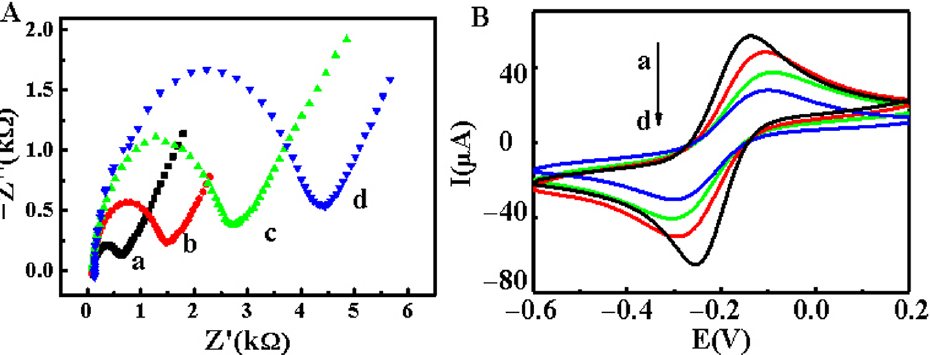
Figure 2. Electrochemical impedance spectra (Nyquist plots) ( A ) and Cyclic voltammograms ( B ) of the different modified electrodes in 0.1 M Tris-HCl buffer solution containing 5 mM (1:1) [Fe(CN) 6 ] 3 − /4 − : (a) Bare GE, (b) H2/GE, (c) H1/H2/GE, and (d) Fc-Ab/H1/H2/GE.